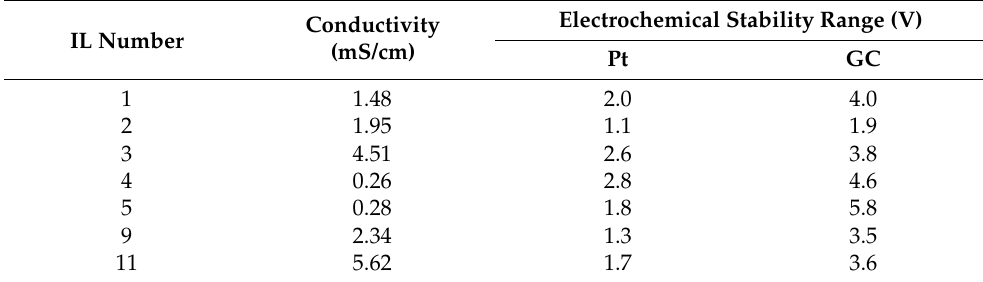
Table 4. Conductivity values and electrochemical stability ranges for the RTILs. Electrochemical Stability Range (V) Conductivity IL Number (mS/cm)